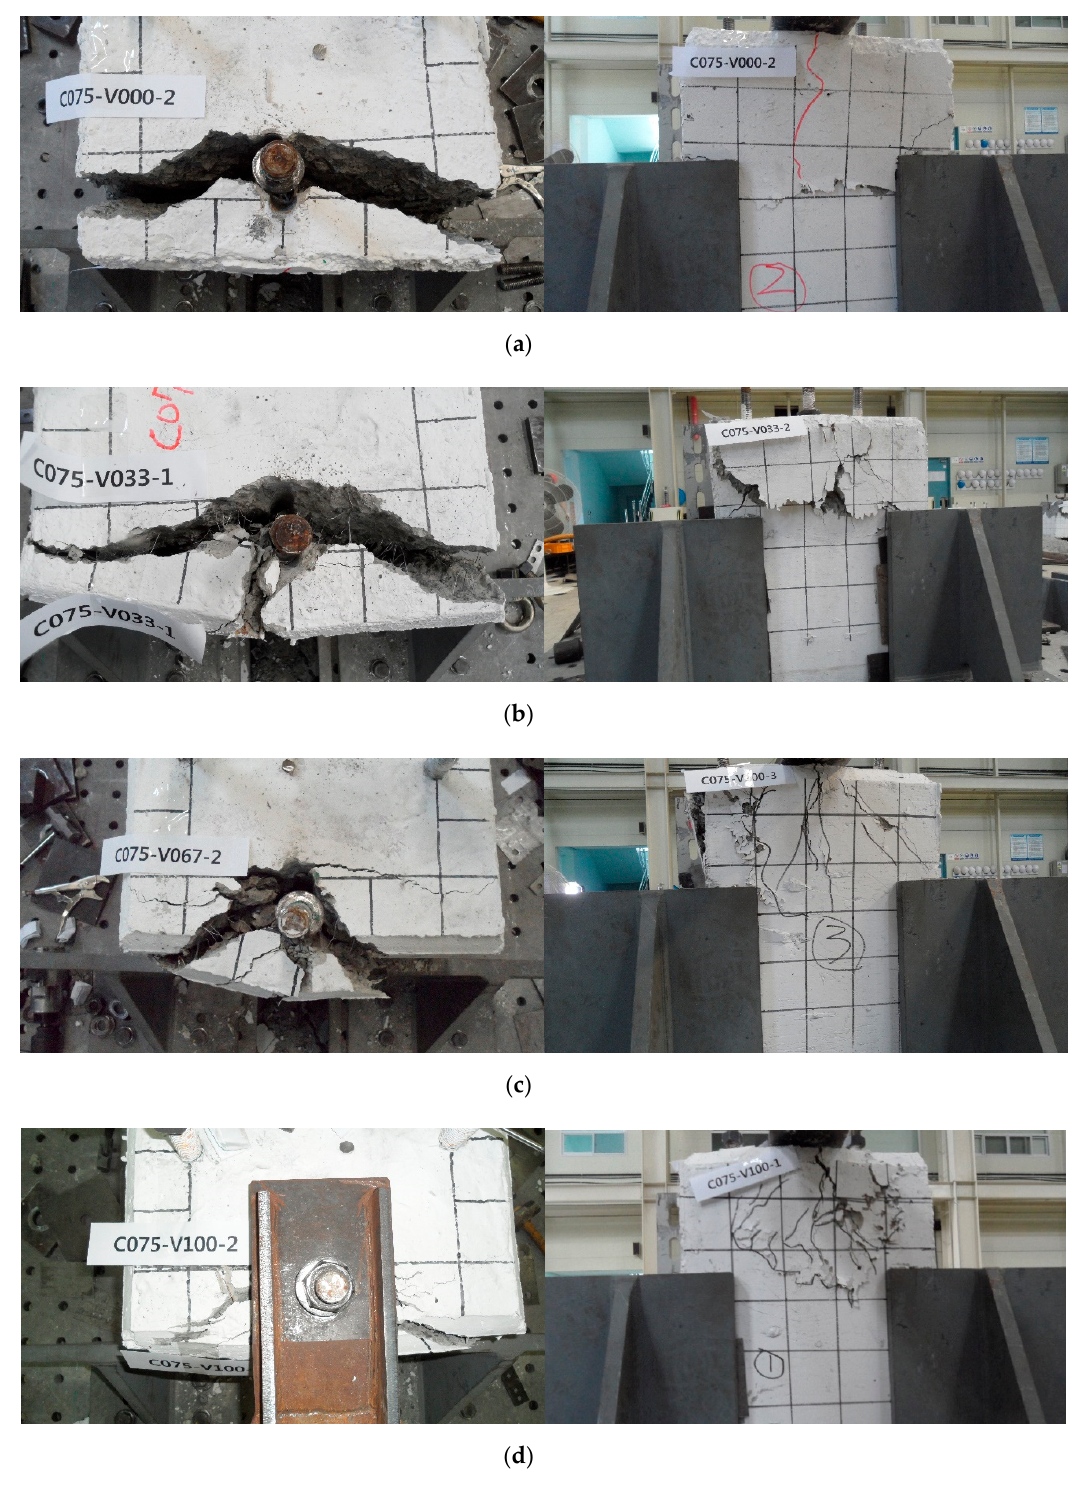
Figure 8. Crack distributions of the concrete anchor block upon concrete breakout failure: ( a ) plain concrete; ( b ) SFRC with 𝑣 (cid:3033) = 0.33%; ( c ) SFRC with 𝑣 (cid:3033) = 0.67%; ( d ) SFRC with 𝑣 (cid:3033) = 1.00%.